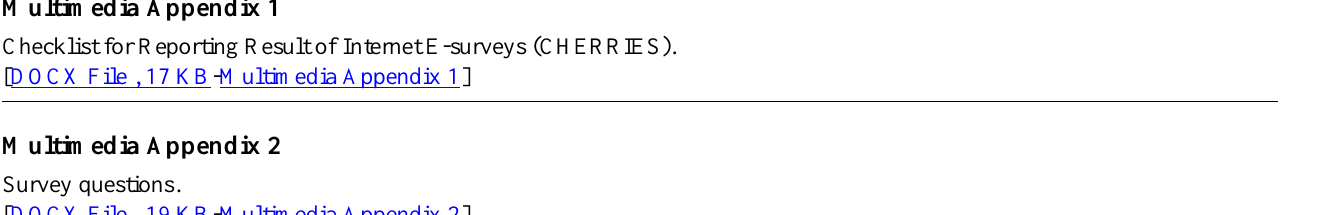
Table S1. Digital literacy characteristics of survey respondents.